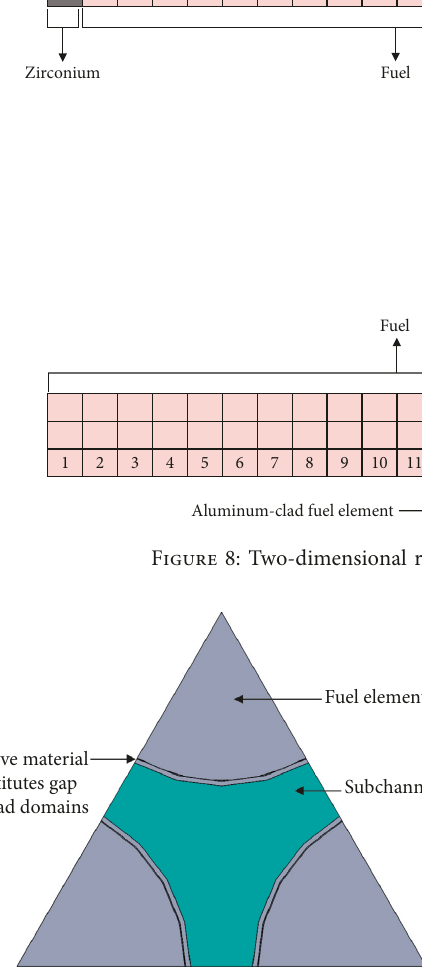
Figure 9: Top view of the COMSOL